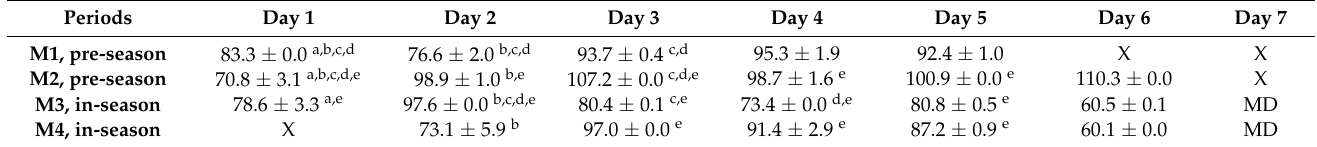
Table 2. Training duration (minutes) during the 7-day testing period for squad average.